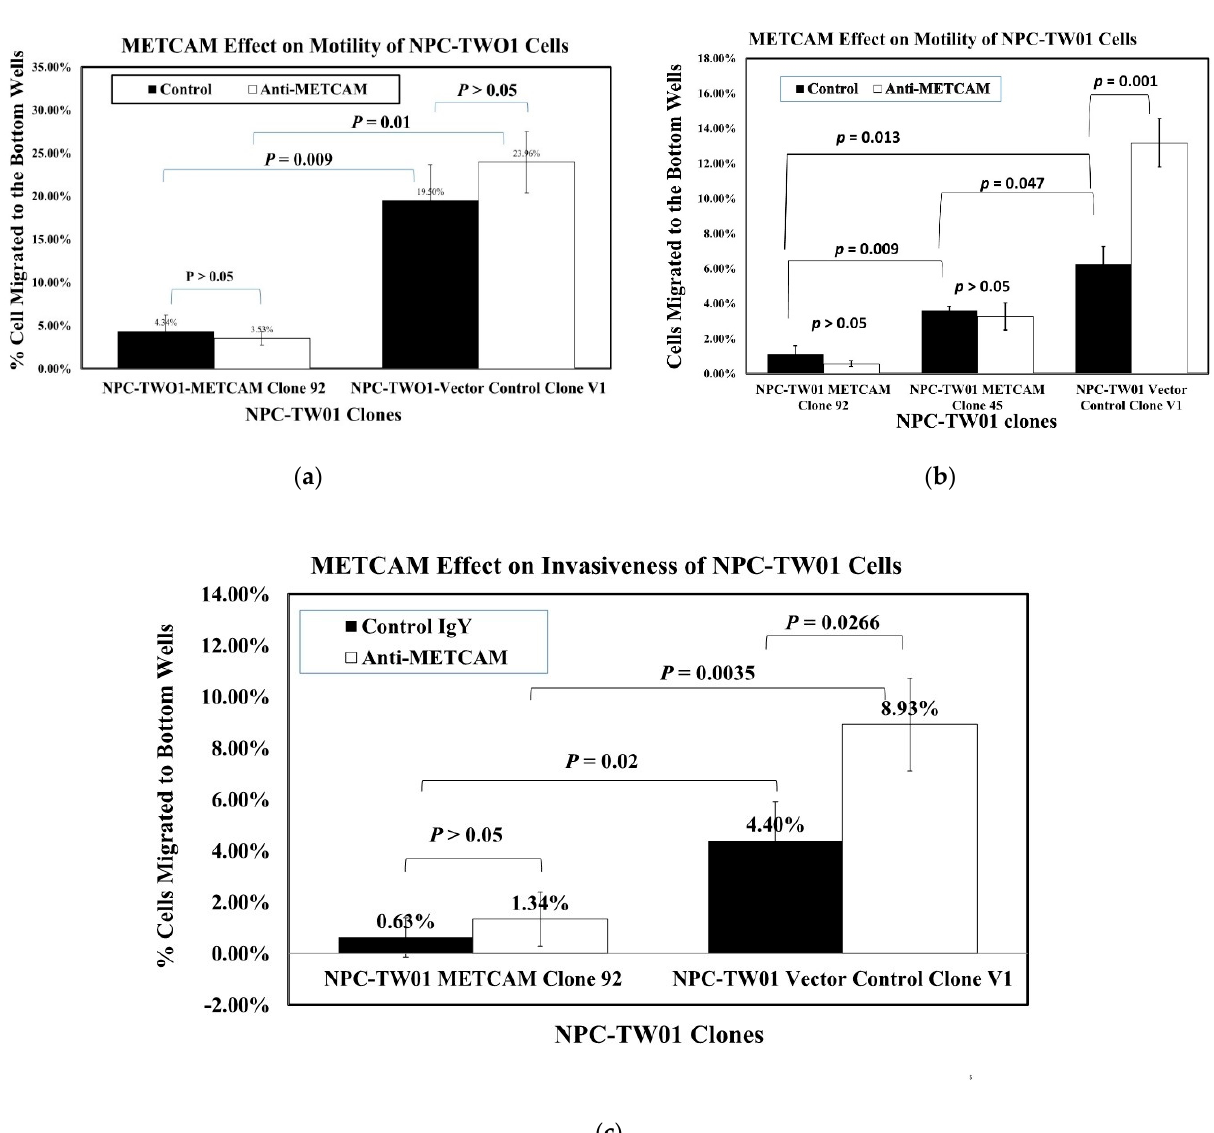
Figure 3. Effects of huMETCAM/MUC18 ′ s over-expression on the in vitro motility ( a ) and invasive- ness ( b ) of the NPC-TW01 cells. All in vitro motility and invasiveness tests were performed in the presence of the anti-huMETCAM/MUC18 antibody or the isotype control IgY, as described in the Section 4 The experiments were repeated three times and the means and standard deviations of the triplicate values are indicated. ( a ) Effects of huMETCAM/MUC18 expression on the in vitro motility of the NPC-TW01 METCAM clone #92 and the vector control clone #V1 ( left panel ) or the NPC- TW01 METCAM clones #92 and #45 and the vector control clone #V1 ( right panel ) were determined either in the presence of anti-huMETCAM/MUC18 antibody or the control chicken IgY. The means and standard deviations of triplicate values of the motility tests are indicated. The p -values were obtained by comparing the motility of clone #92 with the control V1 clone. The p- values were also obtained by comparing the motility of the cells in the presence of the anti-huMETCAM/MUC18 antibody with that of the control IgY. ( b ) Effects of huMETCAM/MUC18 expression on the in vitro invasiveness of the NPC-TW01 METCAM clone #92 and the vector control clone V1 was determined either in the presence of anti-huMETCAM/MUC18 antibody or the control chicken IgY. The means and standard deviations of triplicate values of the invasiveness tests are indicated. The p- values were obtained by comparing the invasiveness of clone #92 with the control V1 clone. The p- values were also obtained by comparing the invasiveness of cells in the presence of the anti- huMETCAM/MUC18 antibody with that of the control IgY.